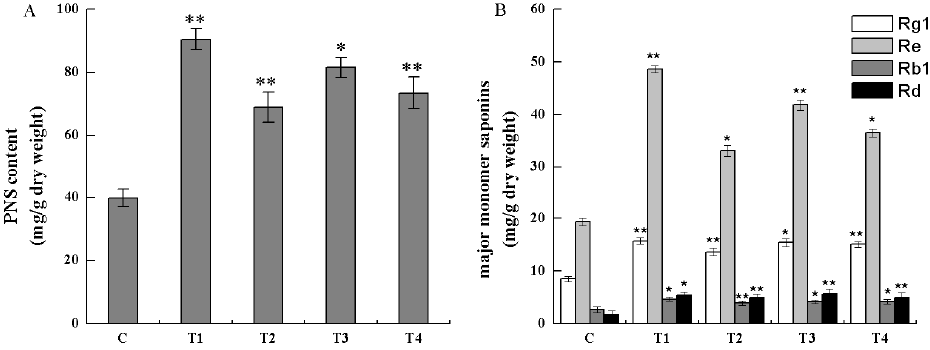
Figure 9. Analysis of saponins in the cell lines (*, p < 0.05; **, p < 0.01).